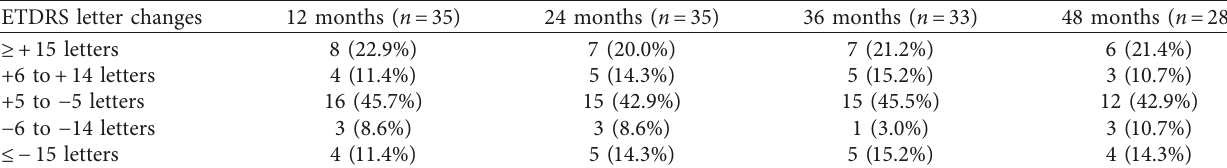
Table 2: Best-corrected visual acuity variation (in ETDRS letters) by groups until 48 months (primary outcome).